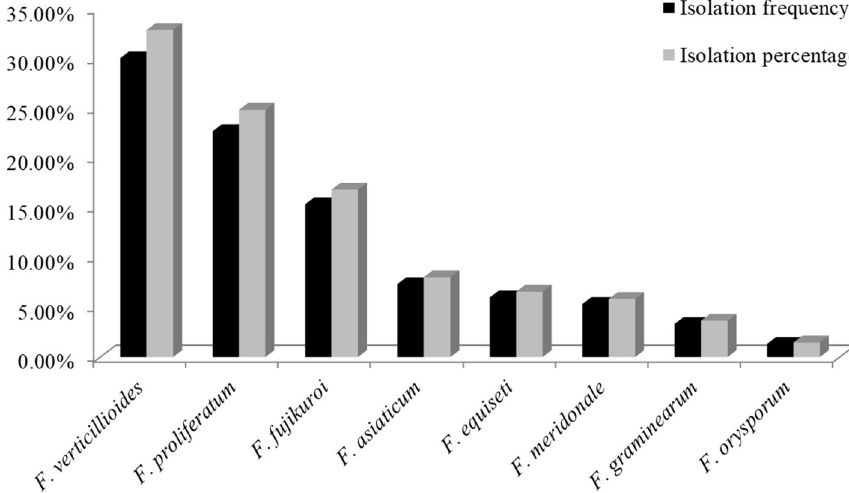
Figure 5. Isolation frequency of Fusarium species from maize sheaths in Sichuan Province, China.